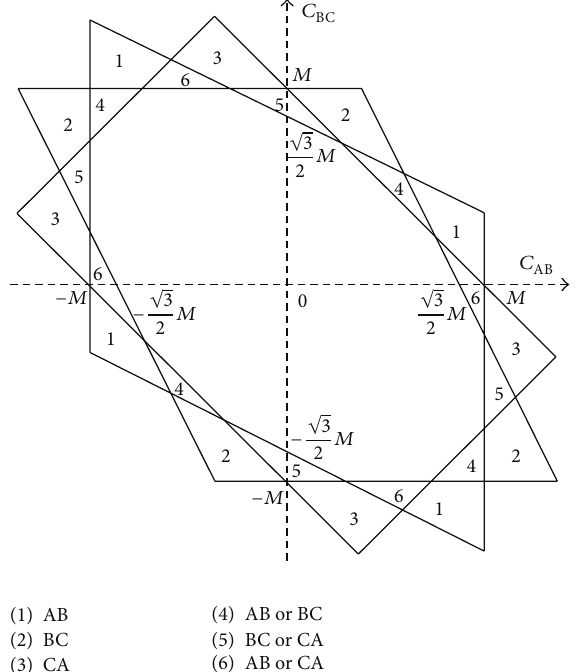
Figure 9: Solvable zones ( (1) equations are solvable if transferring AB first, (2) equations are solvable if transferring BC first, (3) equations are solvable if transferring CA first, (4) equations are solvable if transferring AB or BC first, (5) equations are solvable if transferring BC or CA first, and (6) equations are solvable if transferring AB or CA first).